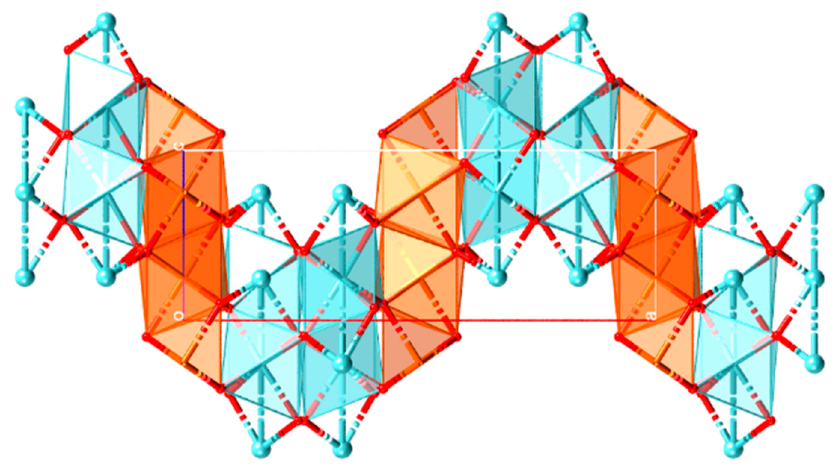
Figure 8. Crystal structure of columbite–tantalite (red line represents the x -axis and blue the z - axis).